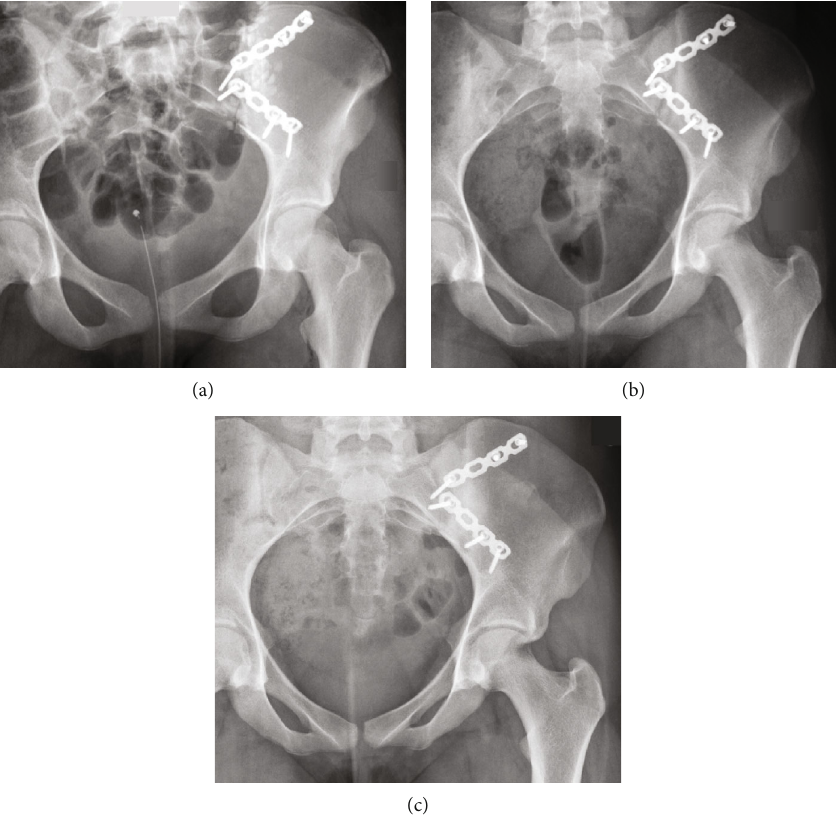
Figure 2: Postoperative anteroposterior pelvic radiograph showing the SI-joint arthrodesis using two plates with radiographically visible Vancomycin-loaded calcium sulphate pellets (a). Three months after surgery (b), the calcium sulphate pellets are totally resorbed. There are no signs of secondary displacement of the SI-joint, implant loosening, or failure. One year after surgery (c), the SI-joint is completely fused.